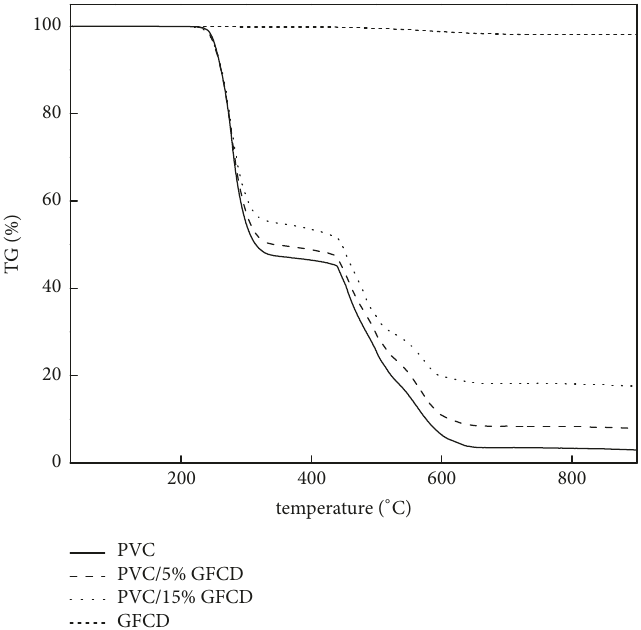
Figure 7: Sample thermograms of TGA of PVC, PVC/GFCD composites and filler used.